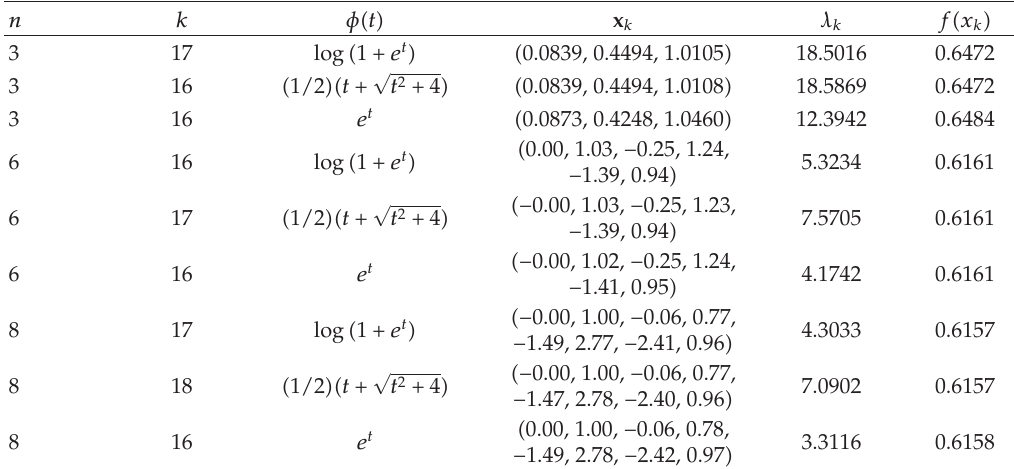
Table 2: Numerical results of Example